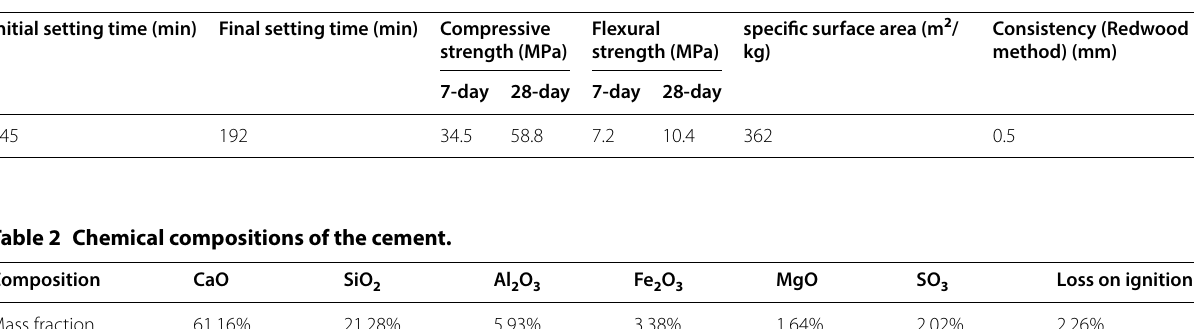
Table 1 Physical properties of cement.